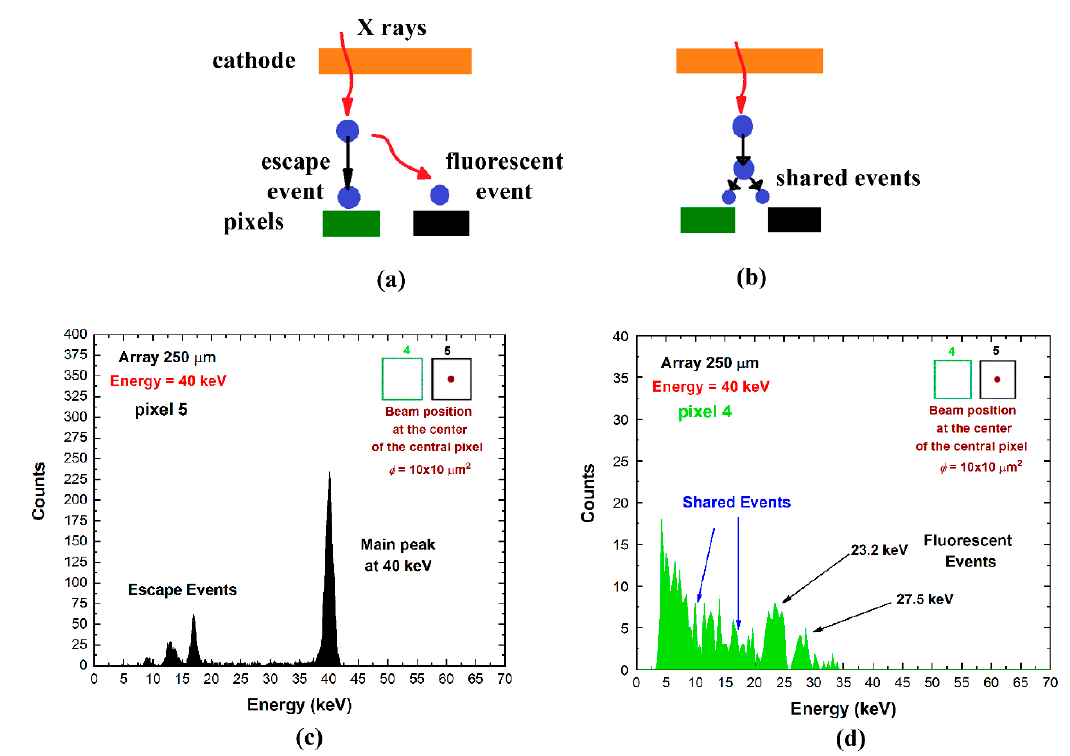
Figure 6. Measurements of fluorescence cross-talk ( a ) and charge-sharing ( b ) events. Energy spectra at 40 keV of two adjacent pixels: ( c ) pixel no. 5 and ( d ) pixel no. 4. We used a collimated X-ray synchrotron beam (10 × 10 µ m 2 ) interacting at the center of the central pixel (black pixel no.5). All events of the adjacent pixel (green pixel no. 4) are in temporal coincidence with the central pixel with multiplicity m = 2.